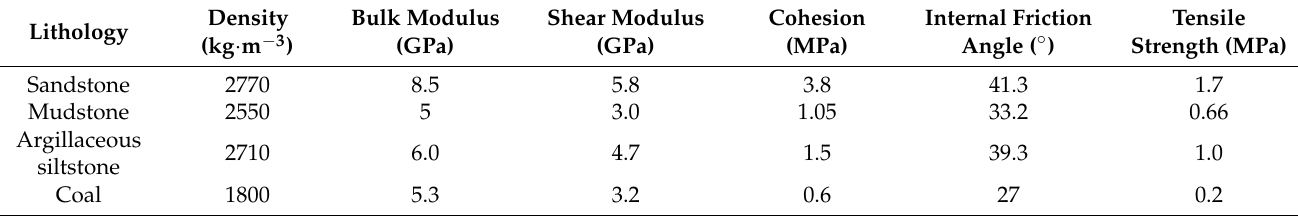
Figure 11. Two-dimensional discrete element model of the Faer slope. Table 2. Physical and mechanical parameters of the rock mass.